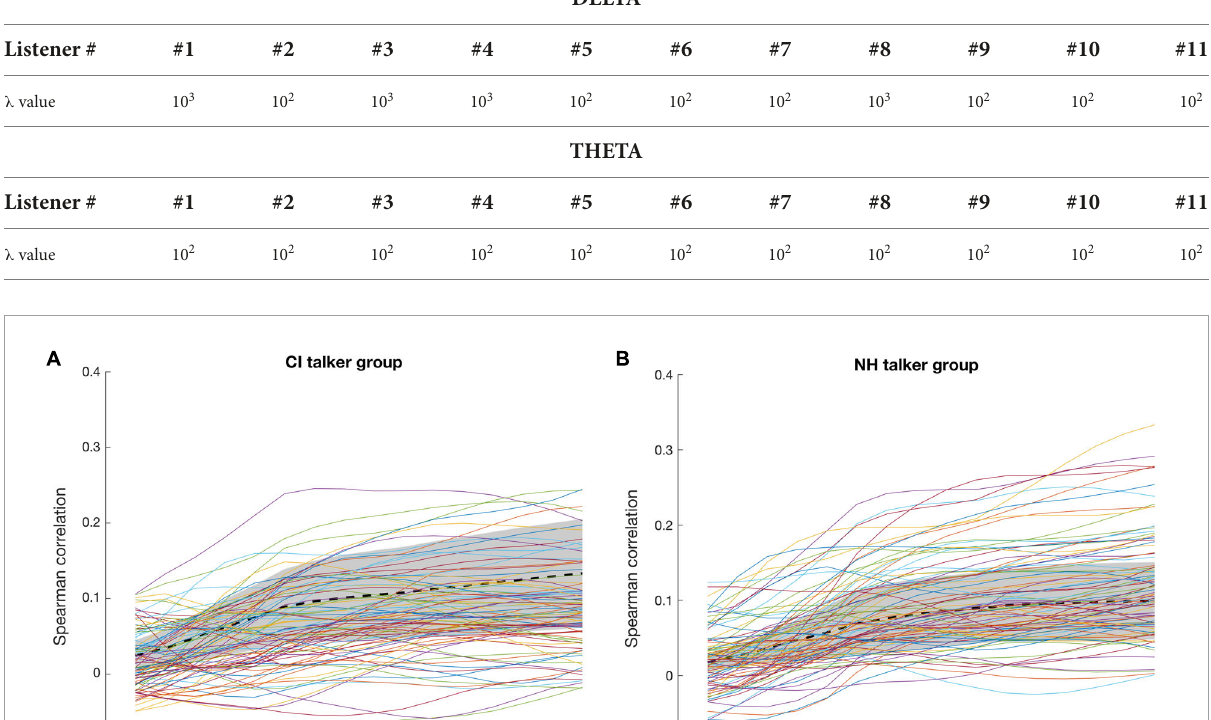
TABLE 3 Individual best λ for NH listeners.